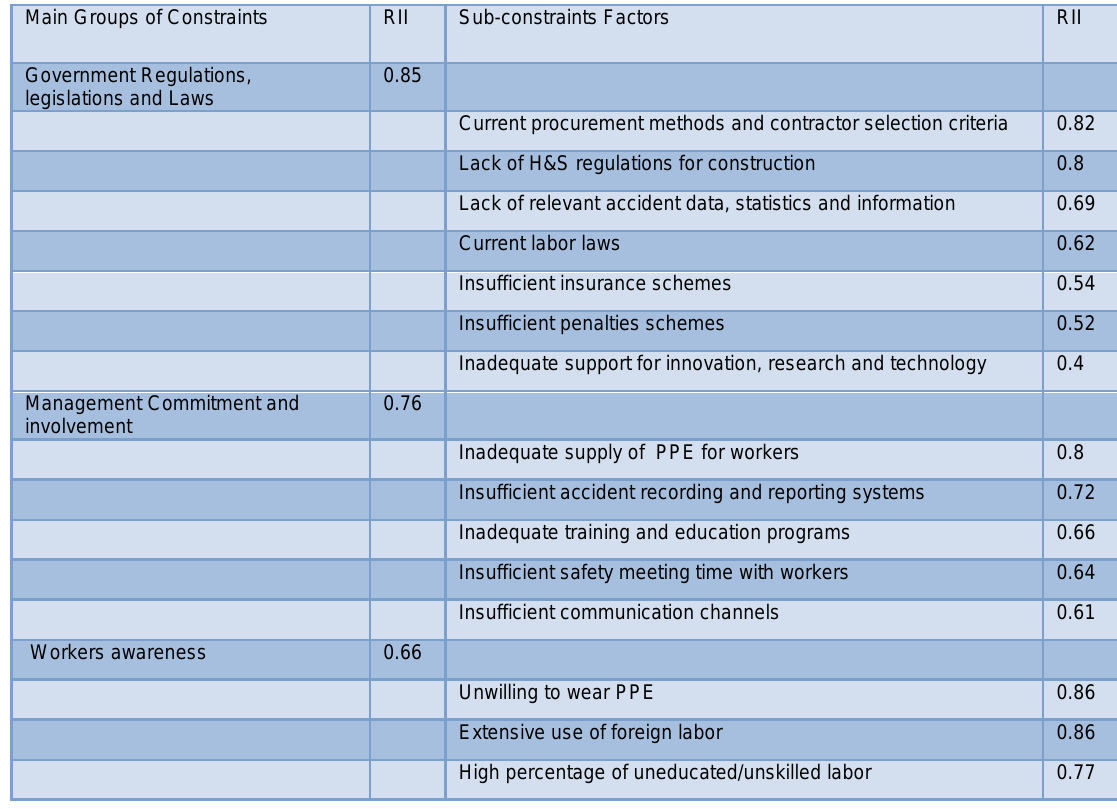
Table 2 Constraints for good health and safety practice For each group a list of underlying issues were identified from the literature review and case study interviews. Stage 3 of the study then asked participants to firstly rank the importance of the three main classes of constraints, and then rank each underlying factor using a 5- Point Likert Scale, where 1 is the least important and 5 is the most. The Relative Importance Index (RII) method (Kometa et al. 1994) was used to calculate the significance of each category’s rank, revealing the significance of three main classes and 15 sub-constraints shown in Table . The RII is computed